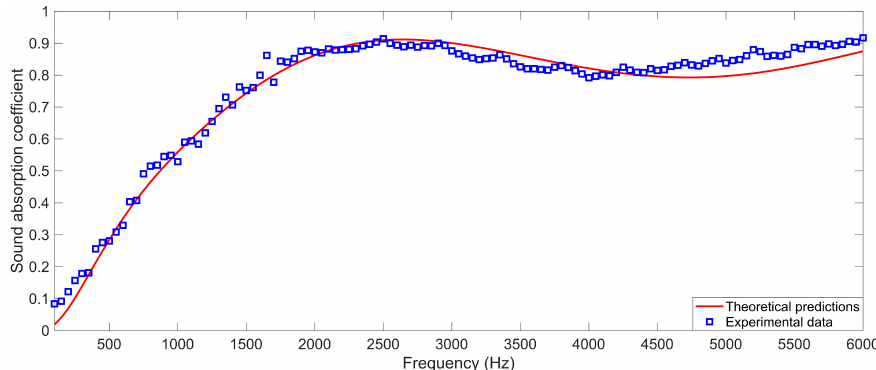
ffi cients of the porous metal with a thickness of 35 Figure 7. Sound absorption coefficients of the porous metal with a thickness of 35 mm. Figure 7. Sound absorption coe